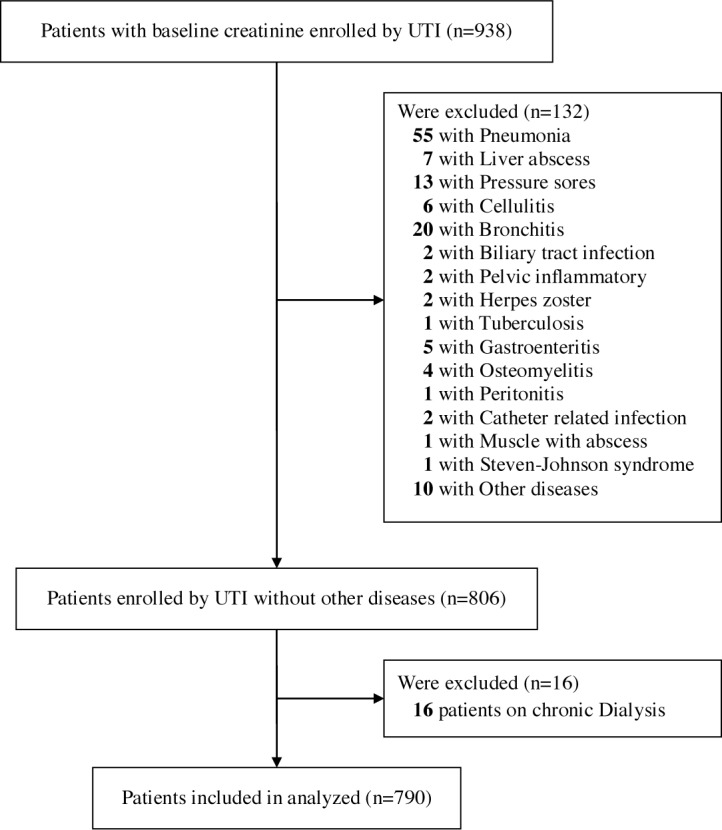
Rectangle below: patients included for analyses.